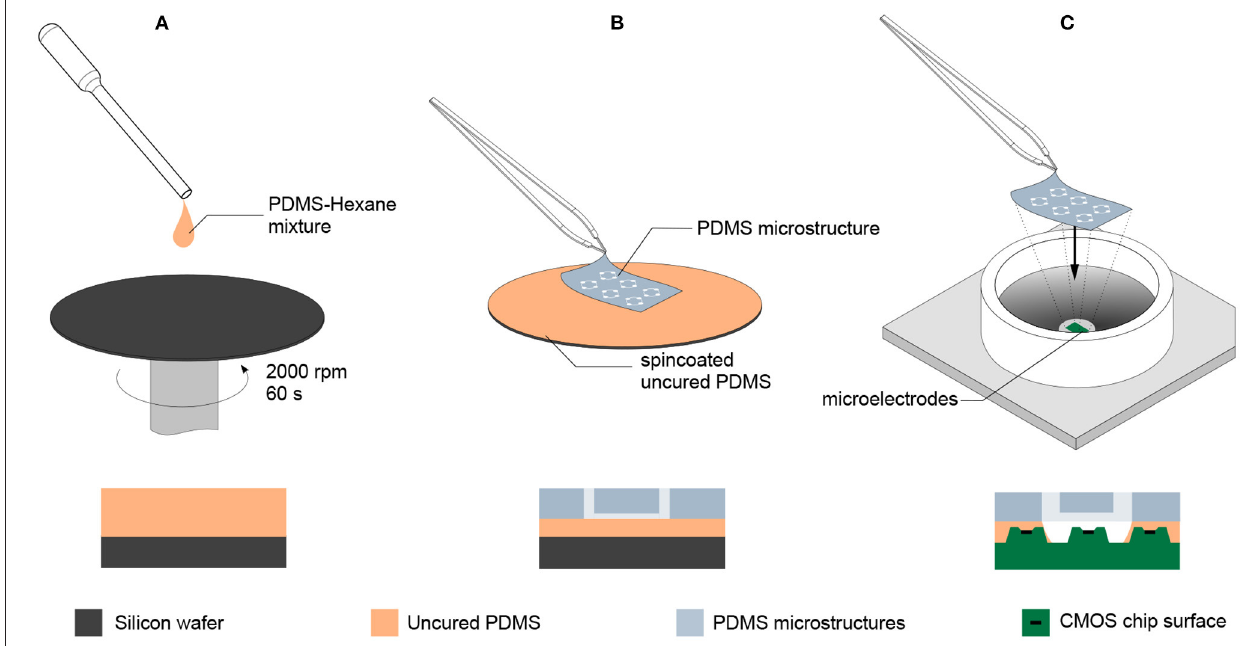
FIGURE 2 | Transferring PDMS microstructures to a CMOS MEA using an intermediate gluing step with uncured PDMS. (A) Uncured PDMS is diluted with hexane in a 1:9 volume ratio and spin coated on a wafer at 2000 rpm for 60 s. (B) The PDMS microstructure is placed on the spin coated PDMS thin film without releasing it and lifted after contact was established, leaving a thin layer of uncured PDMS on the bottom side of the PDMS microstructure. (C) The PDMS microstructure with the intermediate layer of uncured PDMS is placed on the CMOS MEA and subsequently moved to an oven at 80 ◦ C for 2 h to allow the intermediate PDMS layer to fully cure and create a tight seal between the surface of the MEA and the PDMS microstructure.